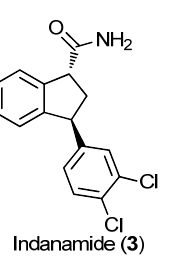
Figure 1. Structure of indanamide ( 3